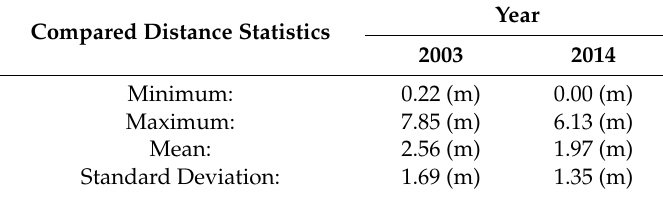
Table 8. Validation of SAR-extracted shorelines with